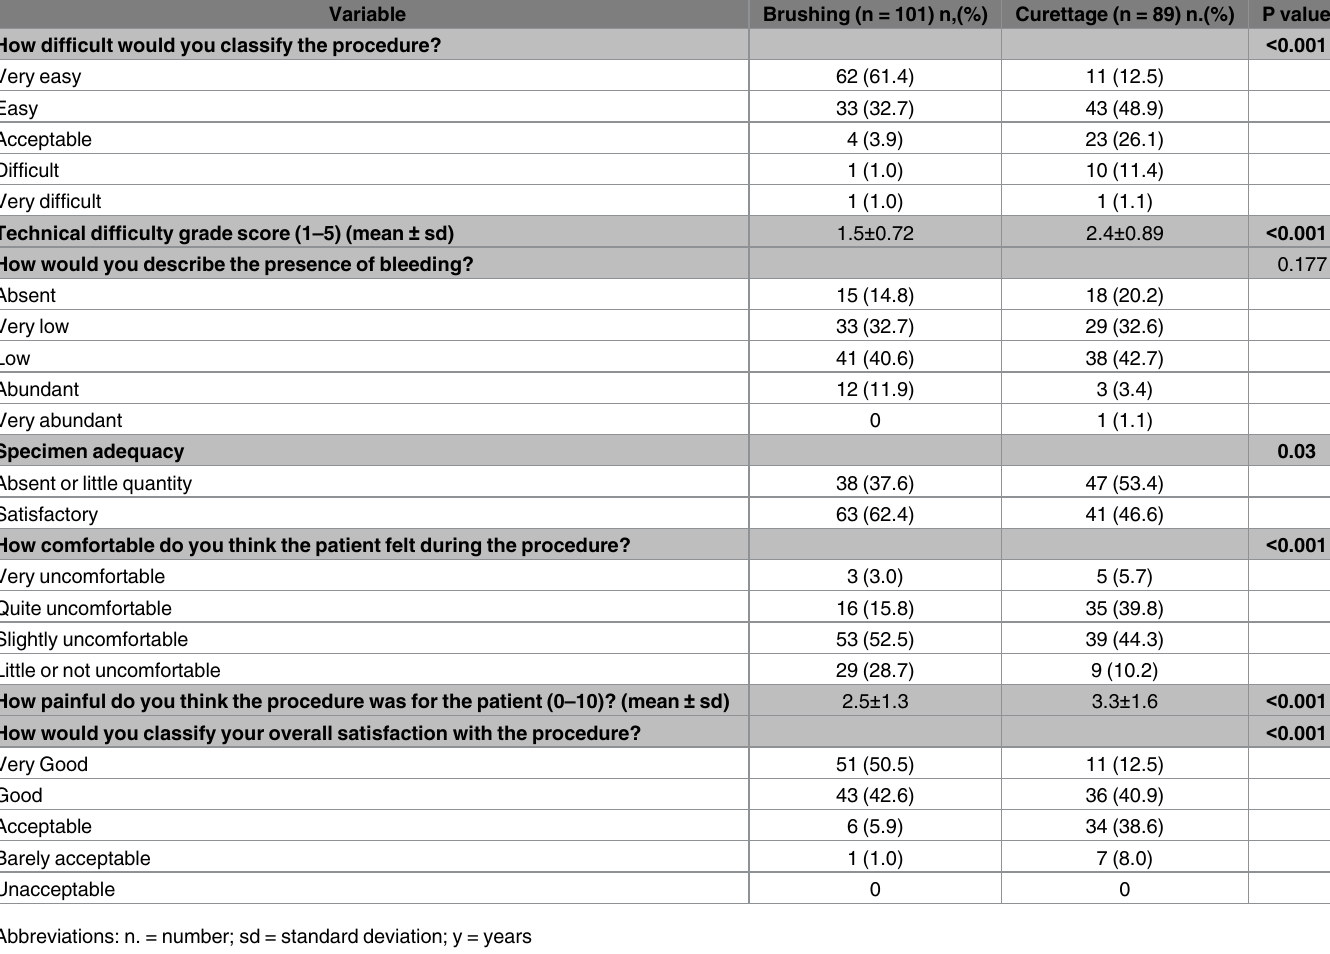
Table 2. Doctors’ perception and evaluation of each procedure (n =